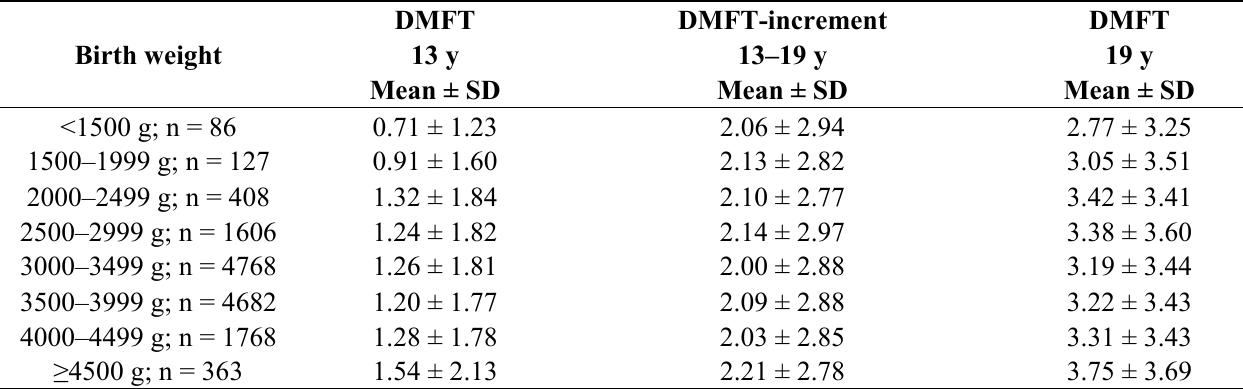
Table 1. Dental caries at 13 and19 years of age in relation to birth